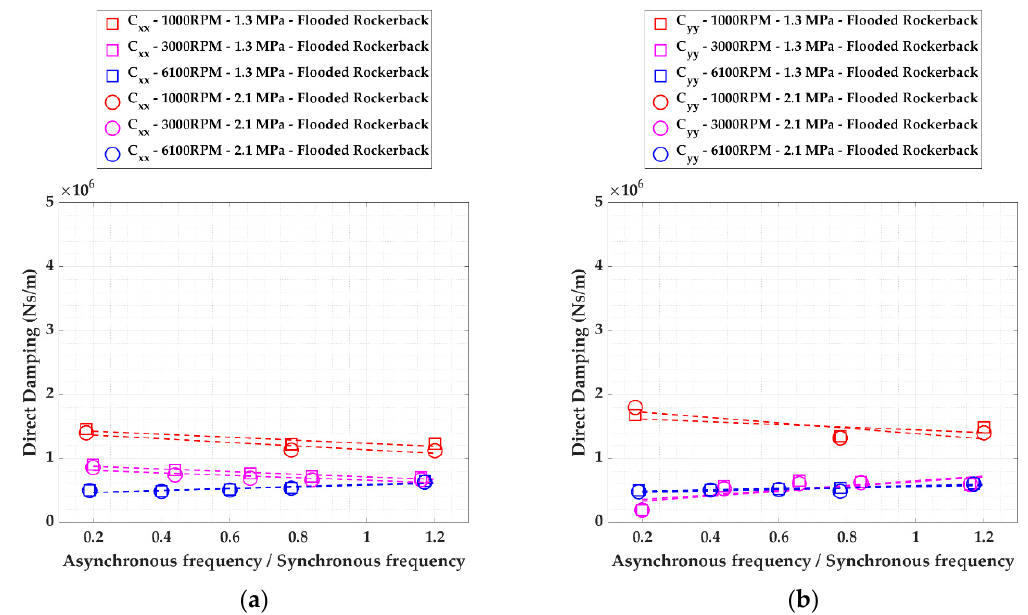
Figure A3. Flooded Rocker Pivot bearing asynchronous direct coefficients at various speeds for 1.3 MPa and 2.1 MPa: ( a ) C xx , ( b ) C yy .